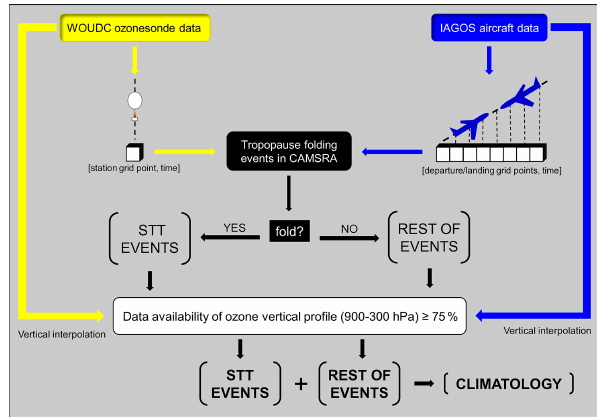
Figure 2. Schematic representation of the methodology applied to select STT